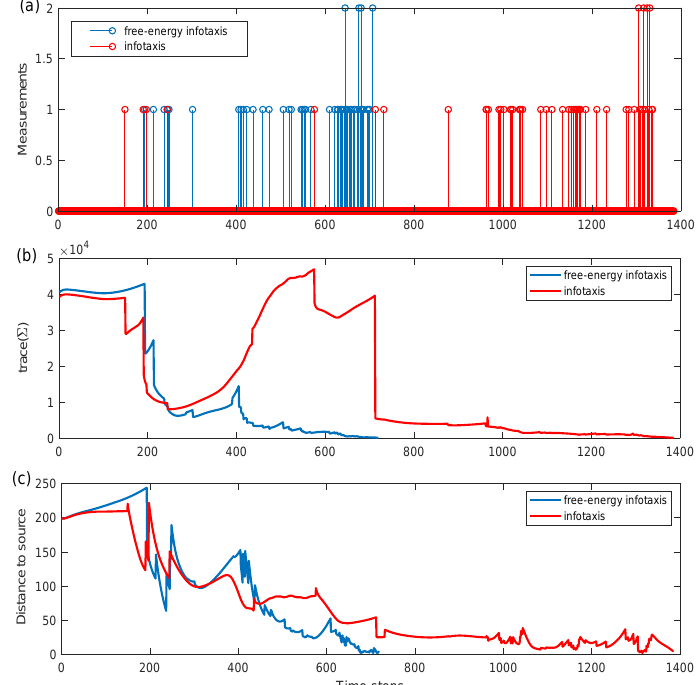
Figure 3. ( a ) The measurements of sensor platform over time; ( b ) the trace of the covariance matrix measuring the spread of the sampled particles; ( c ) the estimated source’s distance to the source over time, marked in red corresponding to Figure 1 and marked in blue corresponding to Figure